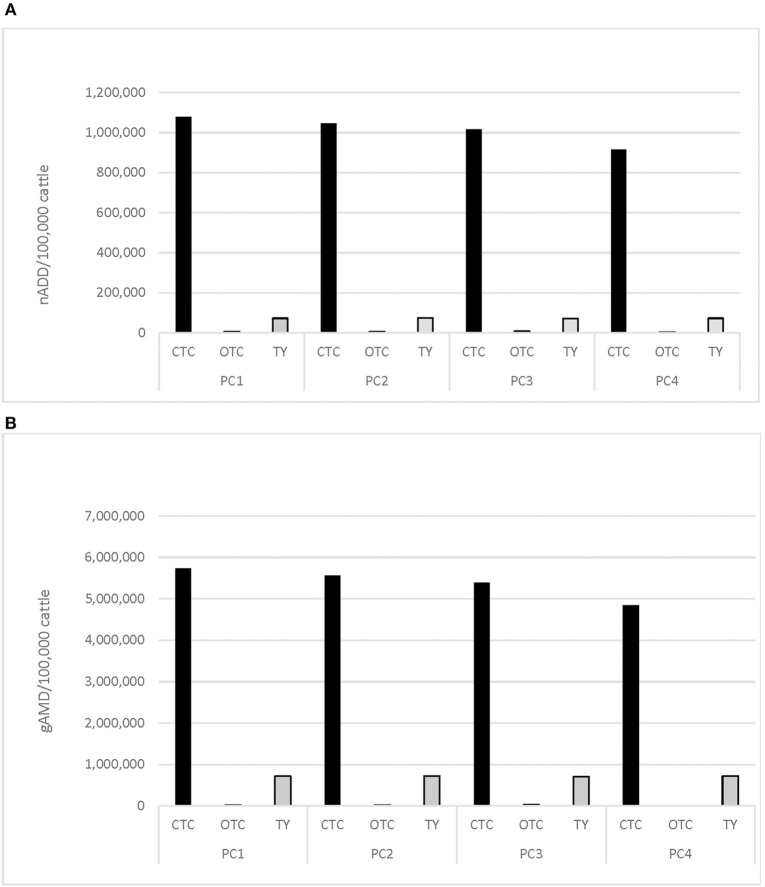
(A) In-feed antimicrobial drug use in nADD/100,000 cattle by placement cohort (PC)a, and antimicrobial classb, cattle placed 2008–2012. (B) In-feed antimicrobial drug use in grams AMD (gAMD)/100,000 cattle by placement cohort (PC)a, and antimicrobial classb, cattle placed 2008–2012.aPlacement cohort comprised of cattle placed in the feedlot between 1 November and 31 October of consecutive years. bCTC, chlortetracycline; OTC, oxytetracycline; TY, tylosin.